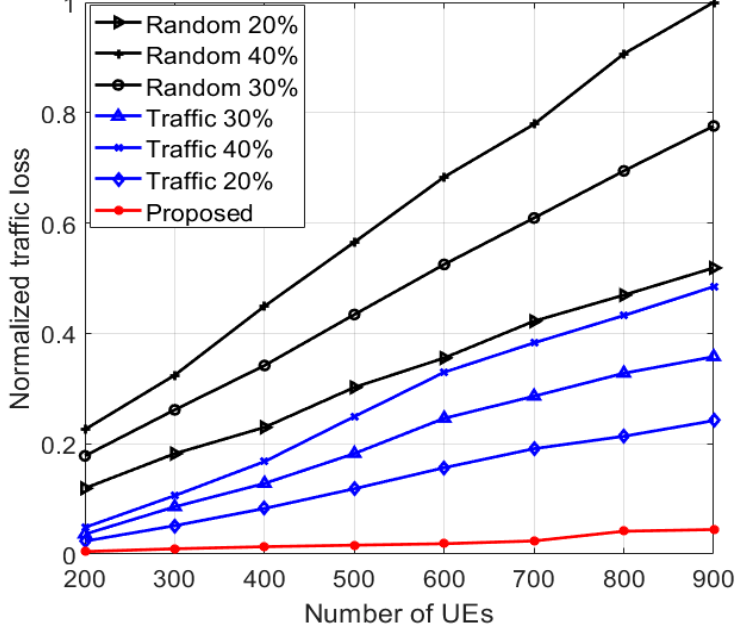
Figure 14. Normalized traffic loss for different numbers of UEs.